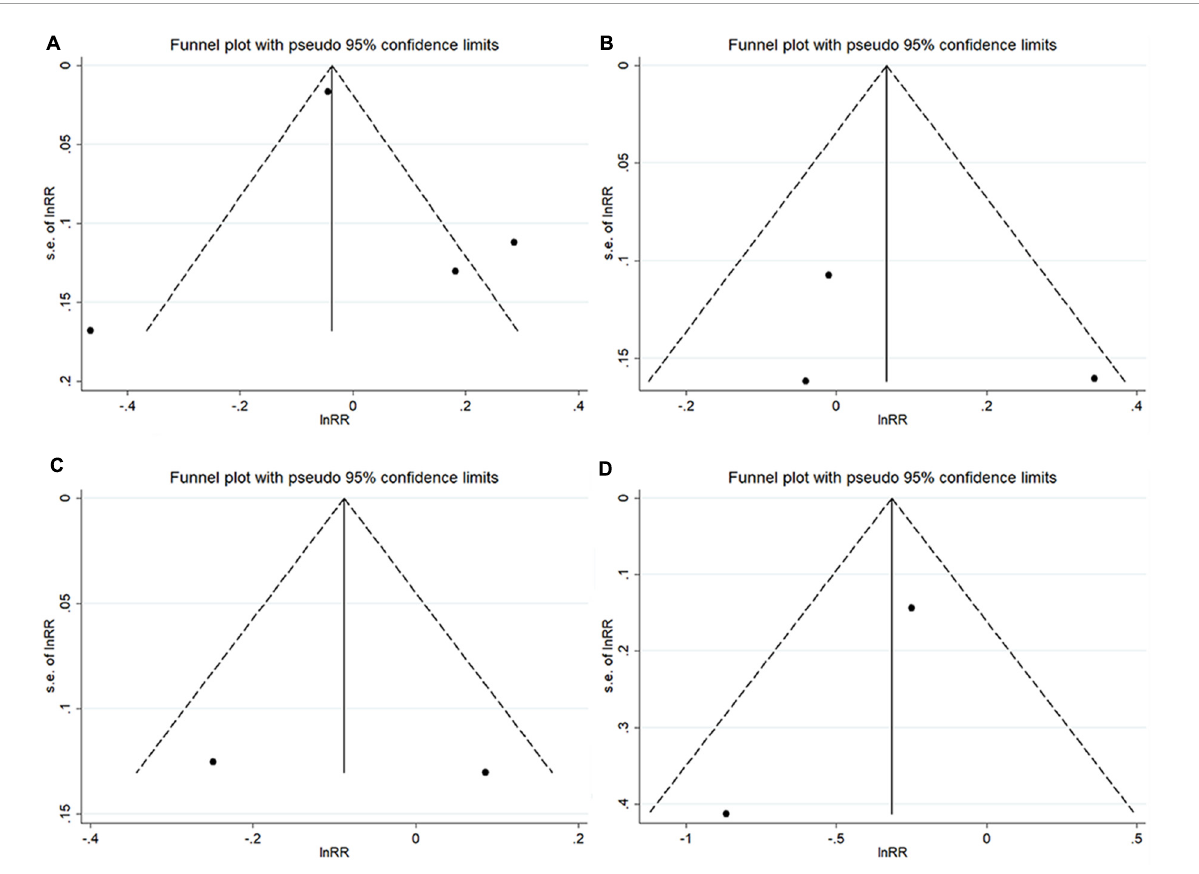
FIGURE4 Funnel plots with pseudo 95% confidence limits among cohort studies. (A) The total testosterone level and atrial fibrillation risk in men; (B) total testosterone level and atrial fibrillation risk in post-menopausal women; (C) estradiol concentration and atrial fibrillation risk in men; and (D) dehydroepiandrosterone sulfate concentration and atrial fibrillation risk in